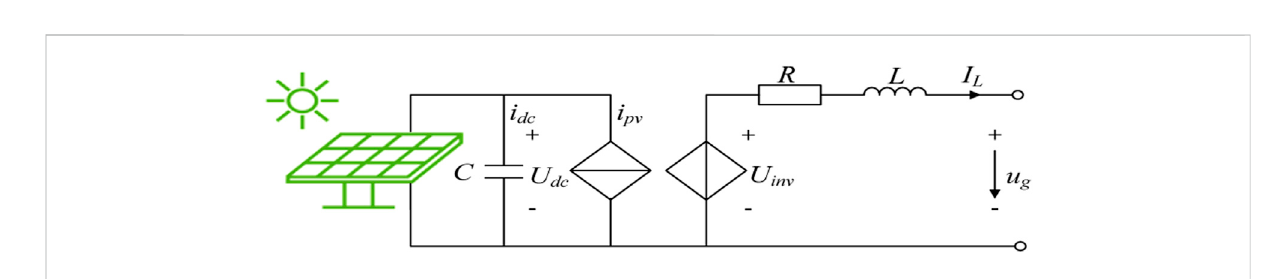
FIGURE 3 Single phase dynamic equivalent model